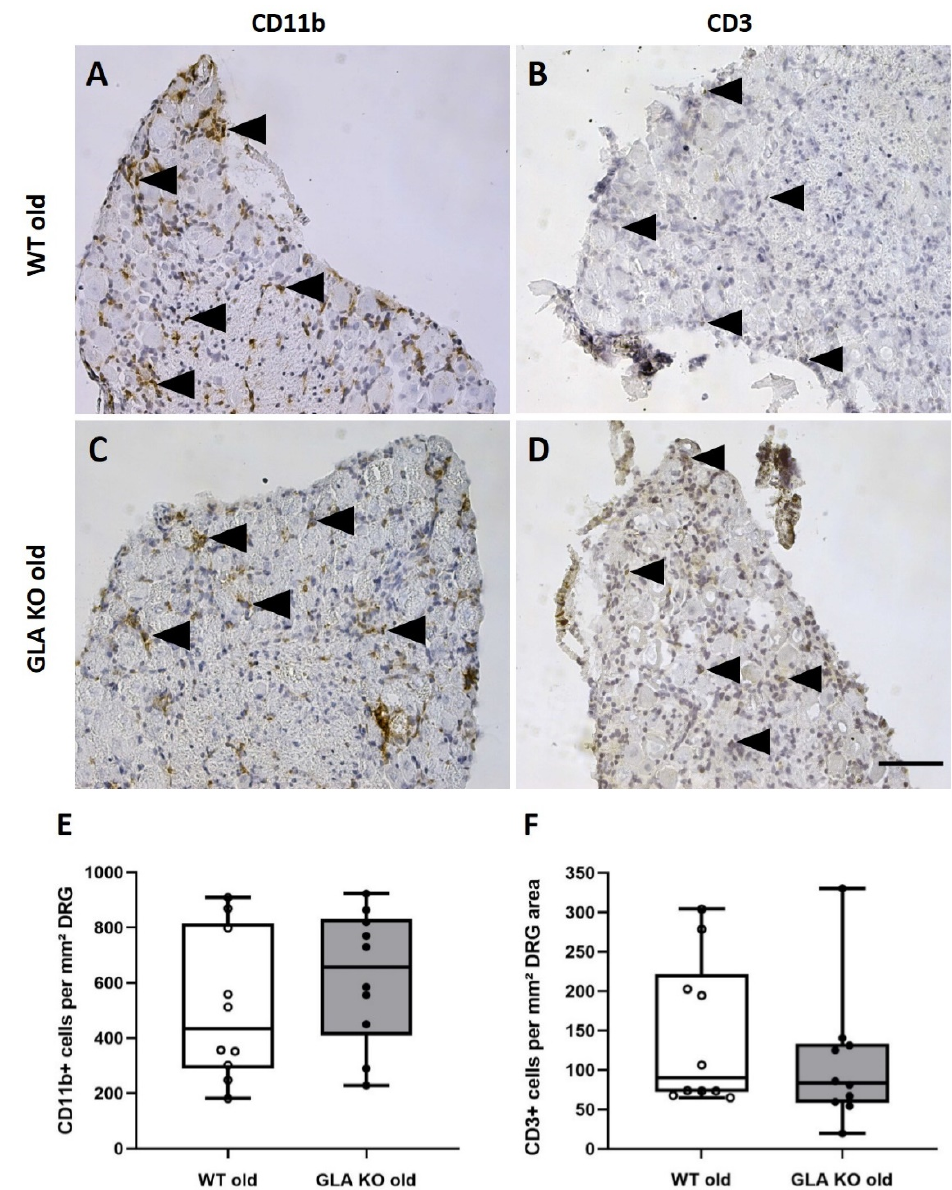
Figure 2. Macrophage and T-cell infiltration in DRG of old WT and GLA KO mice. ( A – D ) Representative photomicrographs of CD11b + macrophages and CD3 + T-cells (arrowheads) in DRG of old WT ( A , B , respectively) and old GLA KO mice ( C , D , respectively). ( E ) Quantification of CD11b + macrophages per mm² DRG area in old WT ( , n = 10) and old GLA KO mice ( , n = 10). ( F ) Quantification of CD3 + T-cells per mm² DRG area in old WT ( , n = 10) and old GLA KO mice ( , n = 10). Abbreviations: CD = Cluster of Differentiation; DRG = dorsal root ganglia; GLA KO = alpha-galactosidase A knockout; WT = wildtype. Scale bar: 100 µm.